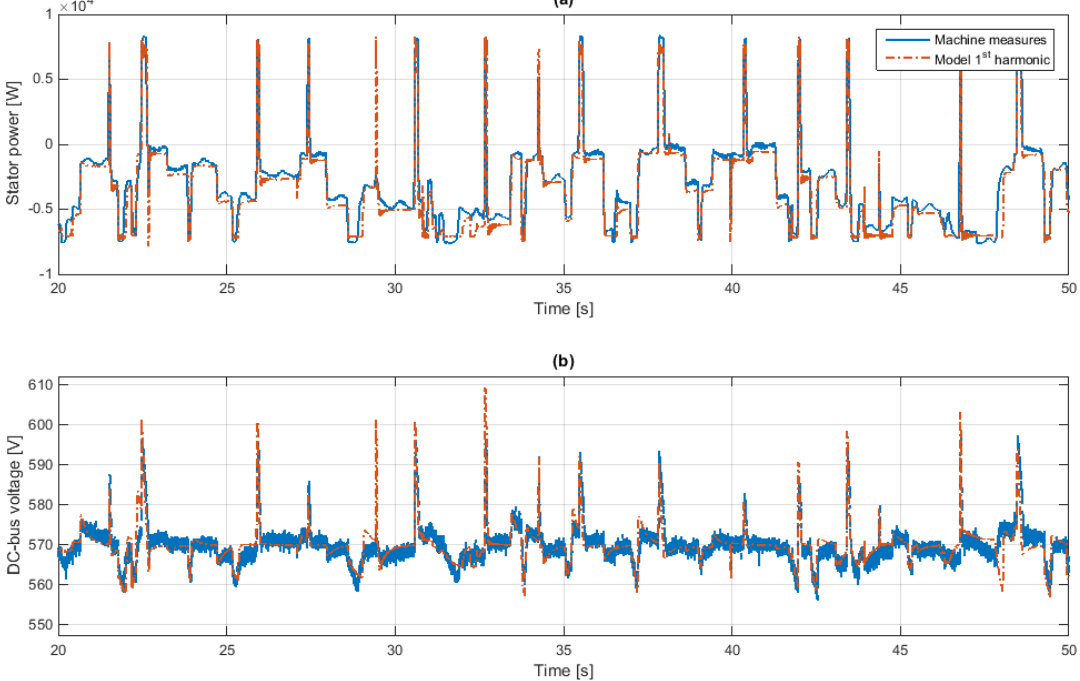
Figure 16. The efficacy of the control implemented in the GenSI and GridSI in the mathematical model compared to the measures of the real machine: power in the stator ( a ) and DC-link voltage ( b